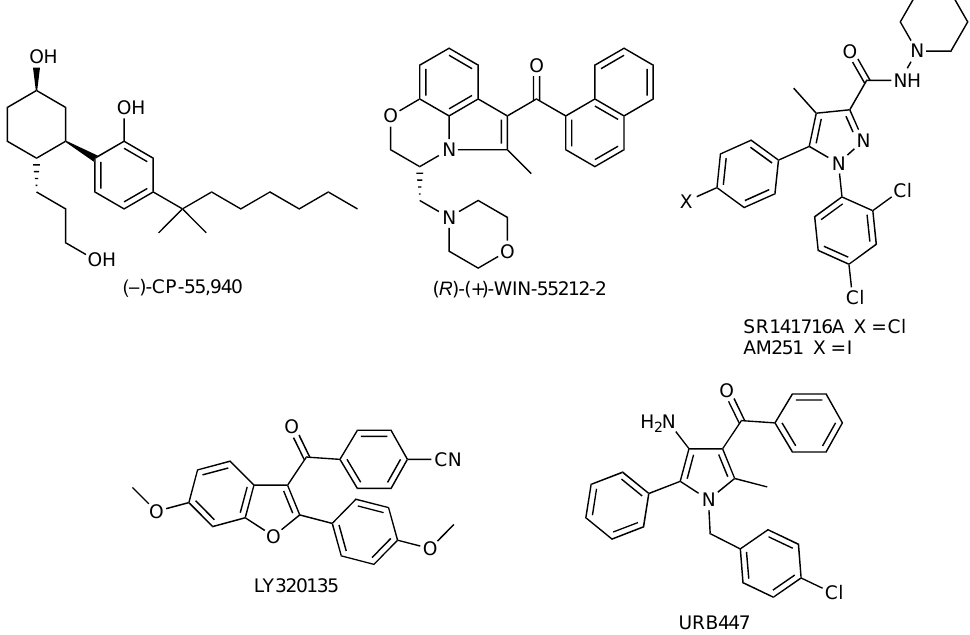
Figure 3. Chemical structures of neuroprotective CB ligands.